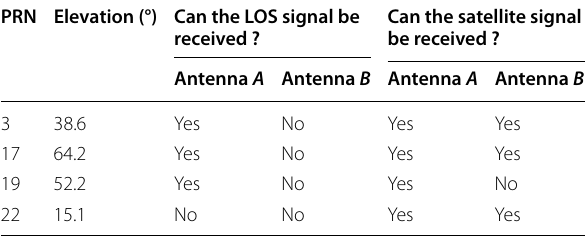
Real‑world short‑term